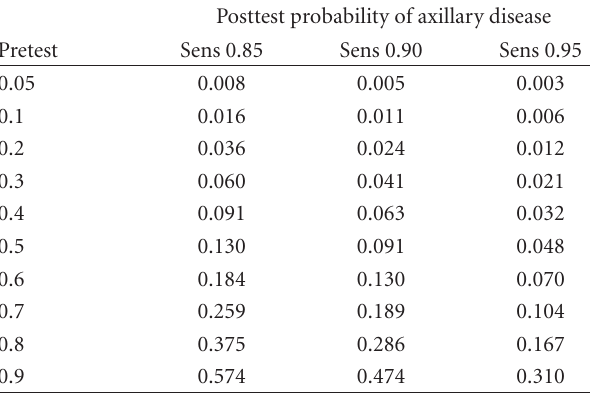
Table 2: Calculated posttest probability of residual axillary disease despite negative SLN biopsy for a range of pretest probabilities for axillary disease with varying sensitivities of SLN